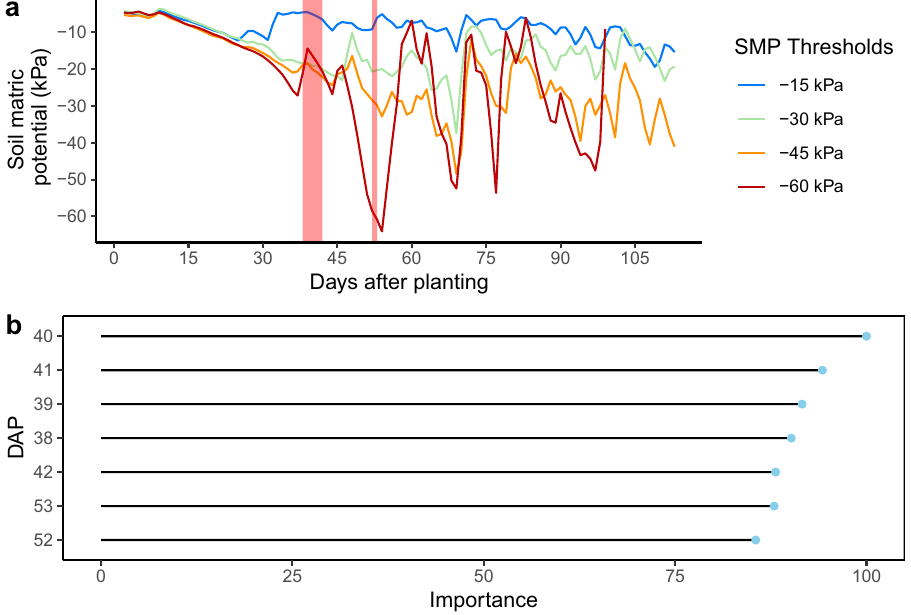
Figure 2. ( a ) Daily average soil matric potential (lines) of Winter 2018 with PLS identification of critical periods (red polygons). The importance reaches its peak between 38 and 42 days after planting (DAP), the first red polygon, and between 52 and 53 DAP. ( b ) Zoom of the days after planting with an importance of over